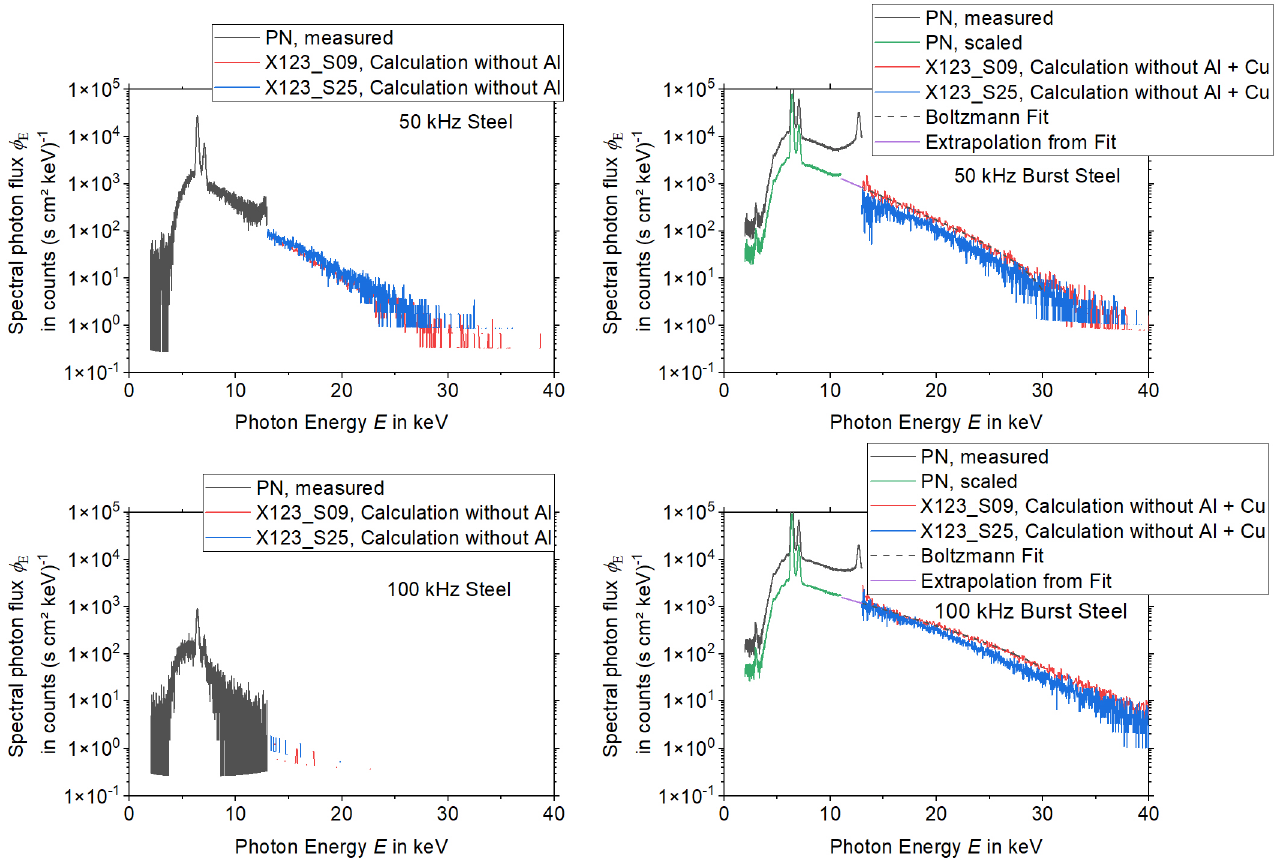
Figure 9. X-ray spectra during the processing of steel. Detector type, filter materials, and evaluation constraints are indicated through labels for the different curves. Note the logarithmic scaling of the ordinate axes.